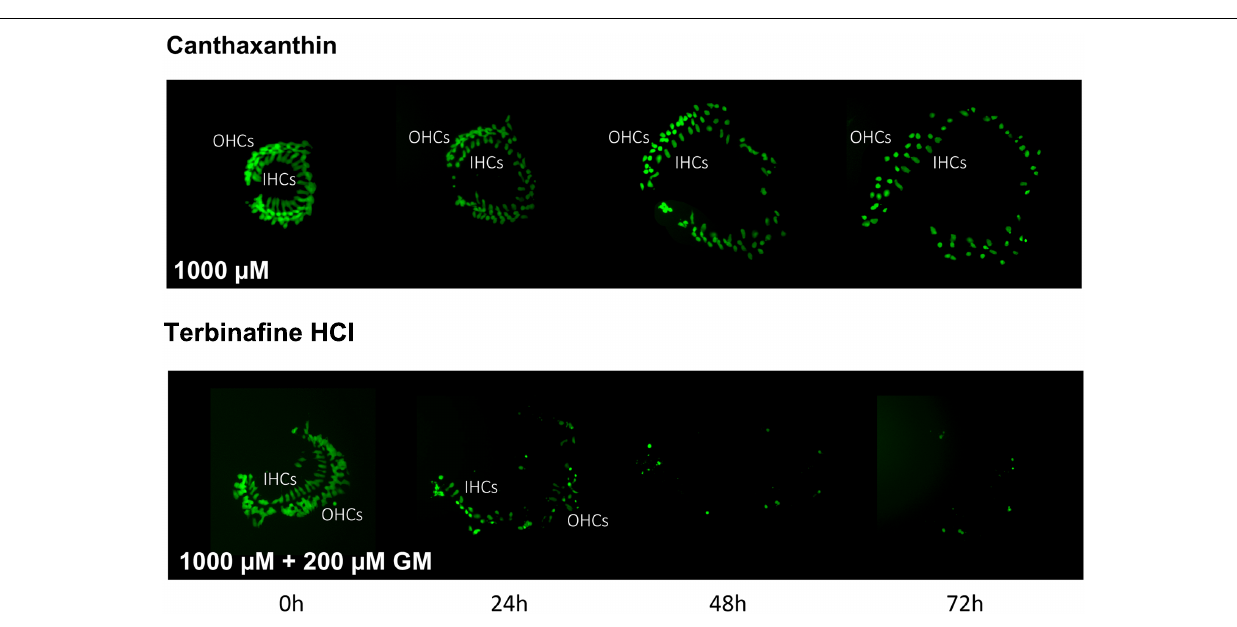
FIGURE 4 | Montages illustrating representative oC micro-explants treated with 1000 µ M canthatraxin alone, or 100 µ M terbinafine HCl plus 200 µ M gentamicin, for 72